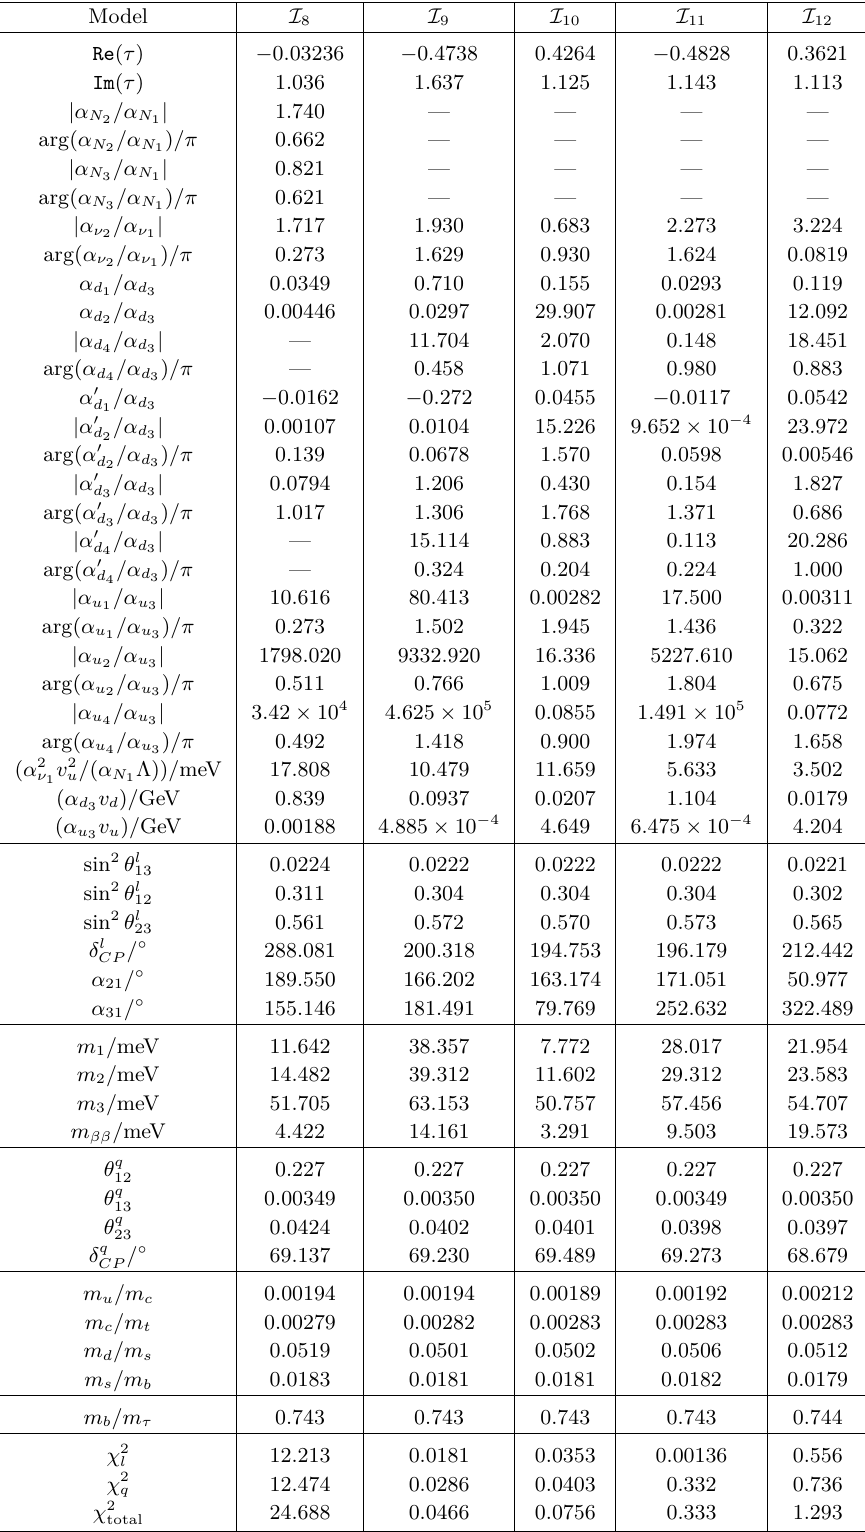
Table 6 . The best fit values of the free parameters and the corresponding predictions for lepton and quark mixing parameters and fermion masses for the phenomenologically viable models of Type-I (continuation of table